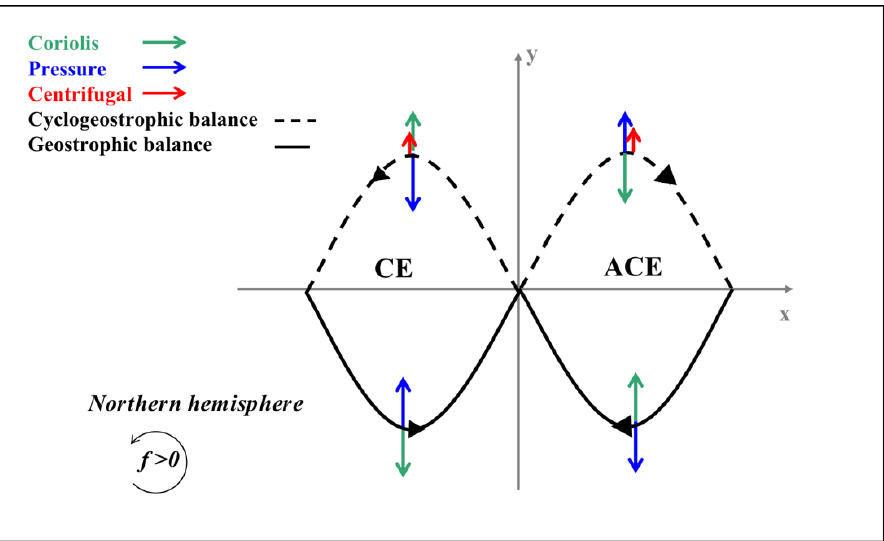
Figure 1. The force diagram of a cyclonic eddy (CE) and an anticyclonic eddy (ACE) under geostrophic and cyclogeostrophic conditions.